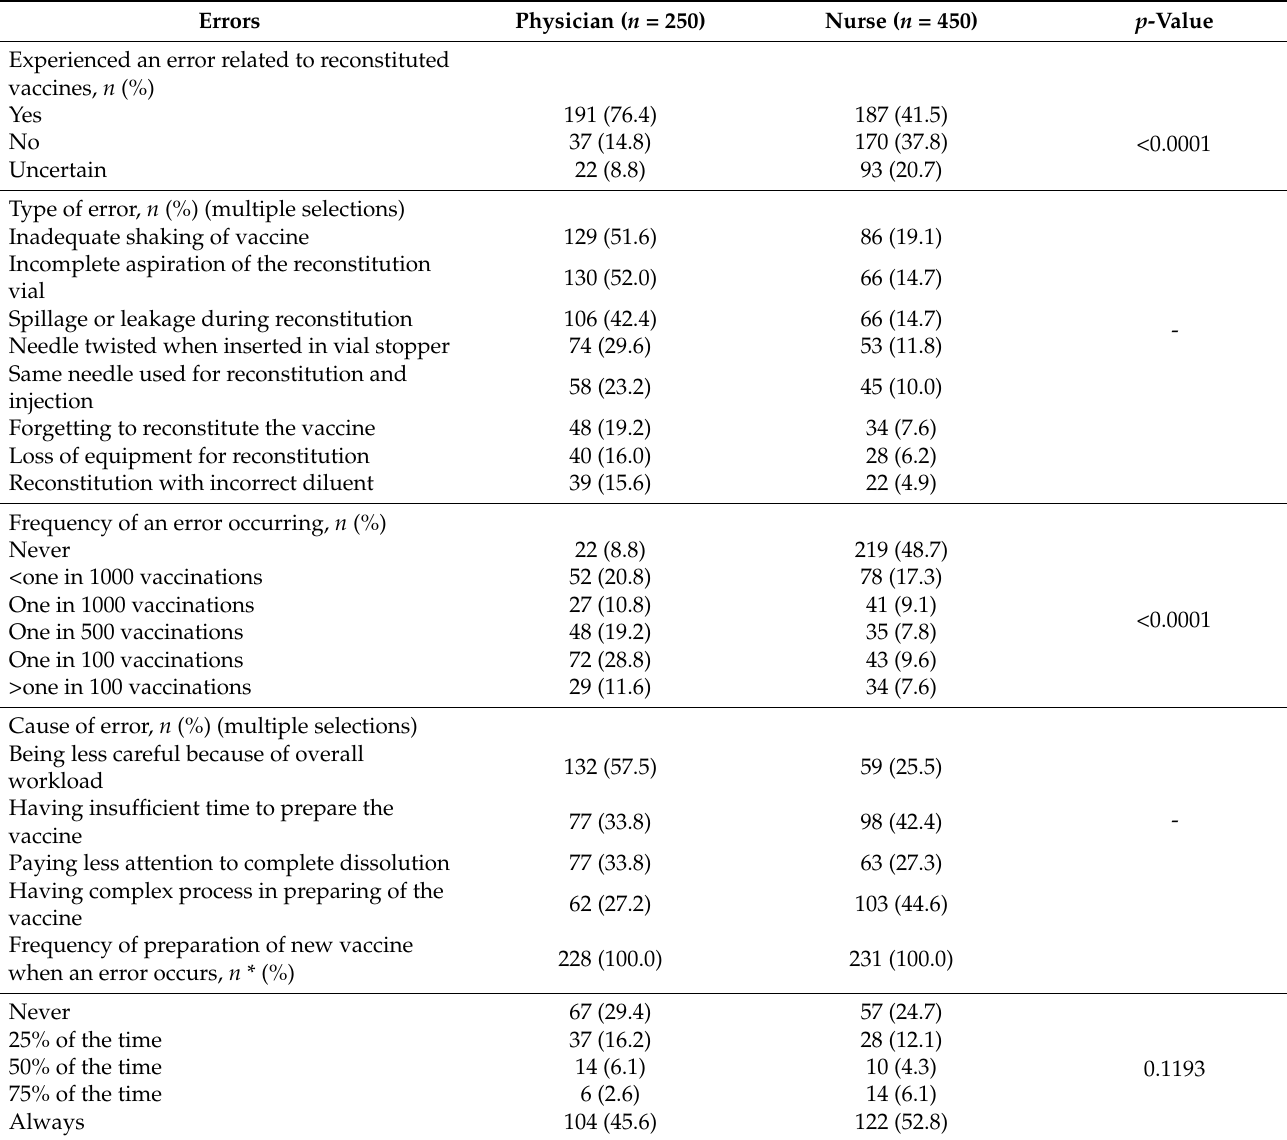
Table 2. Reported error or related problems regarding reconstituted vaccines by